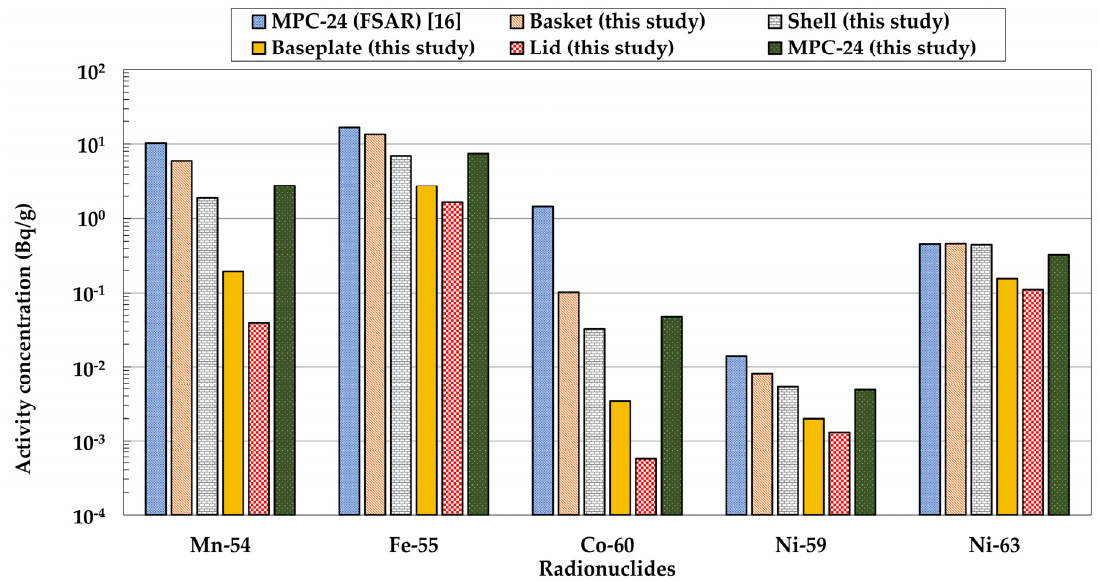
Figure 7. Comparison of residual radioactivity concentrations of major activation products in each component of the MPC-24 and as a whole calculated in this study, together with the results provided in the HI-STORM 100 final safety analysis report (FSAR).